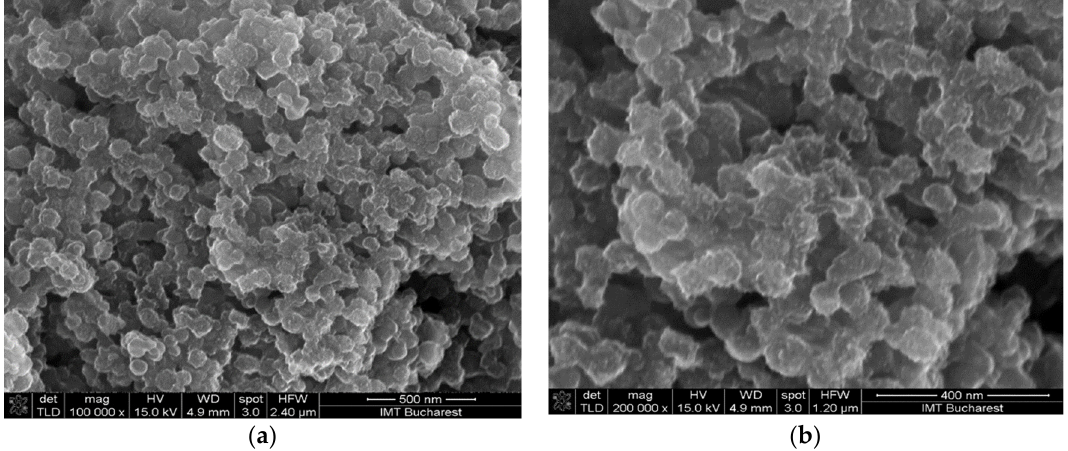
Figure 7. Scanning electron micrographs of the GO/CNHox/PVP at 1:2:1 w/w/w ratio: ( a ) ×100,000 magnification; ( b ) ×200,000 magnification.